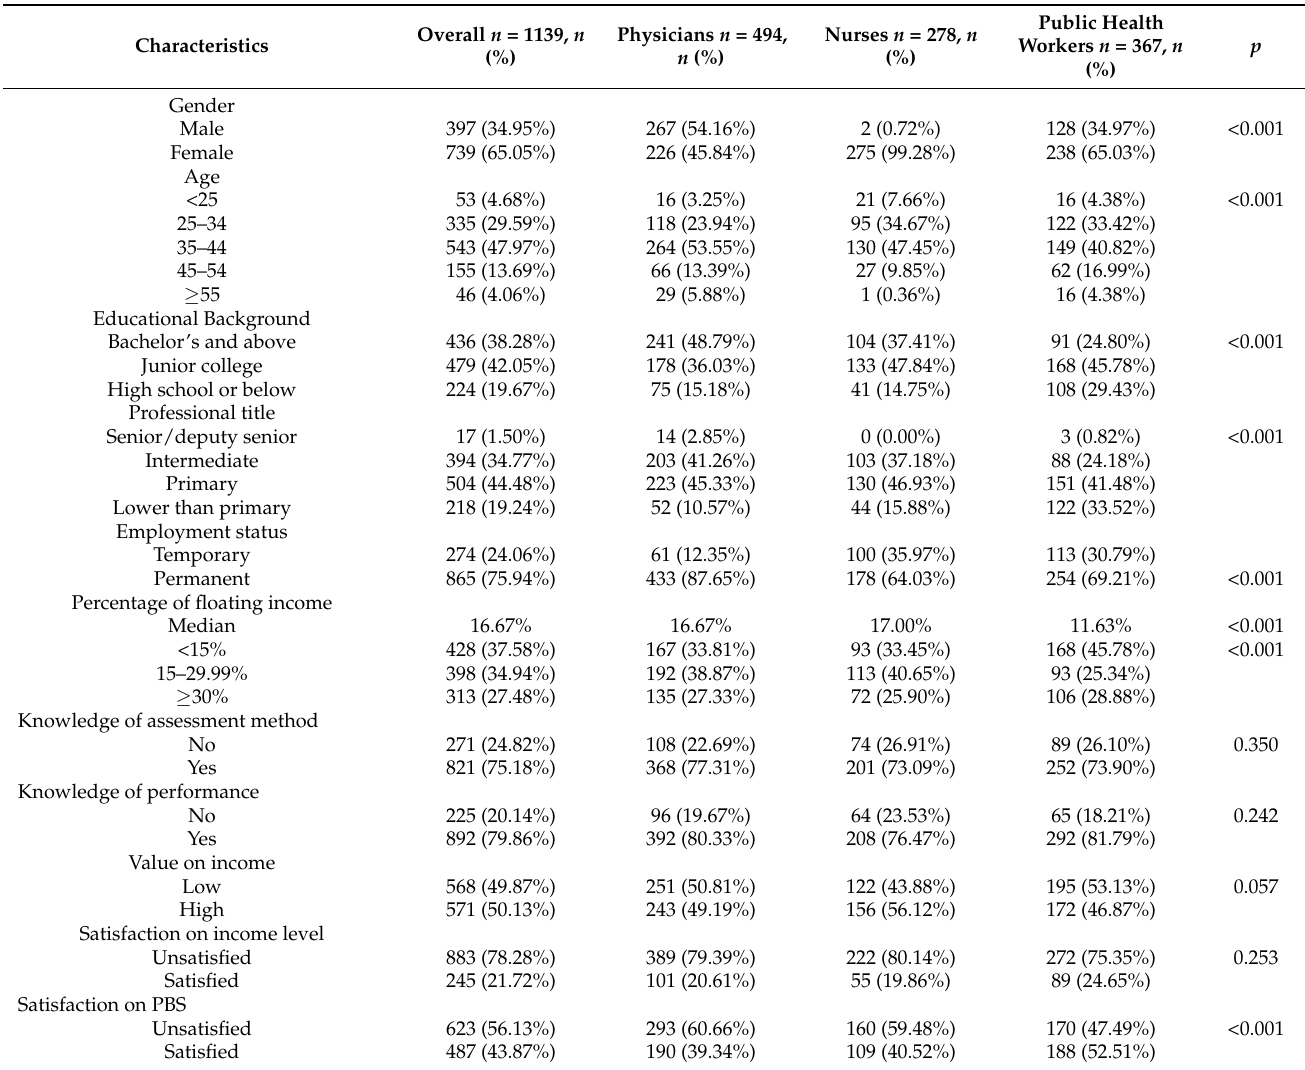
Table 1. Characteristics of investigated health workers in